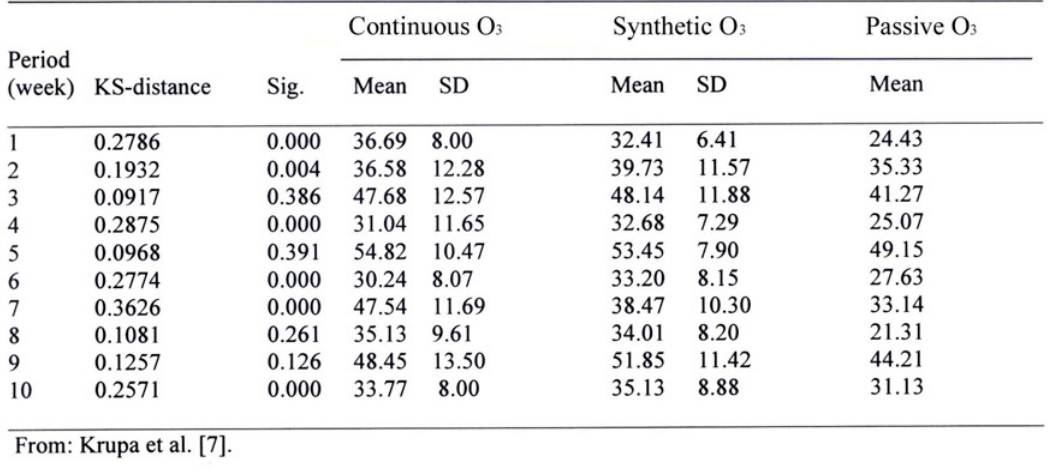
Summary Statistics of the Kolmogorov-Smirnov (KS) Test for Goodness of Fit